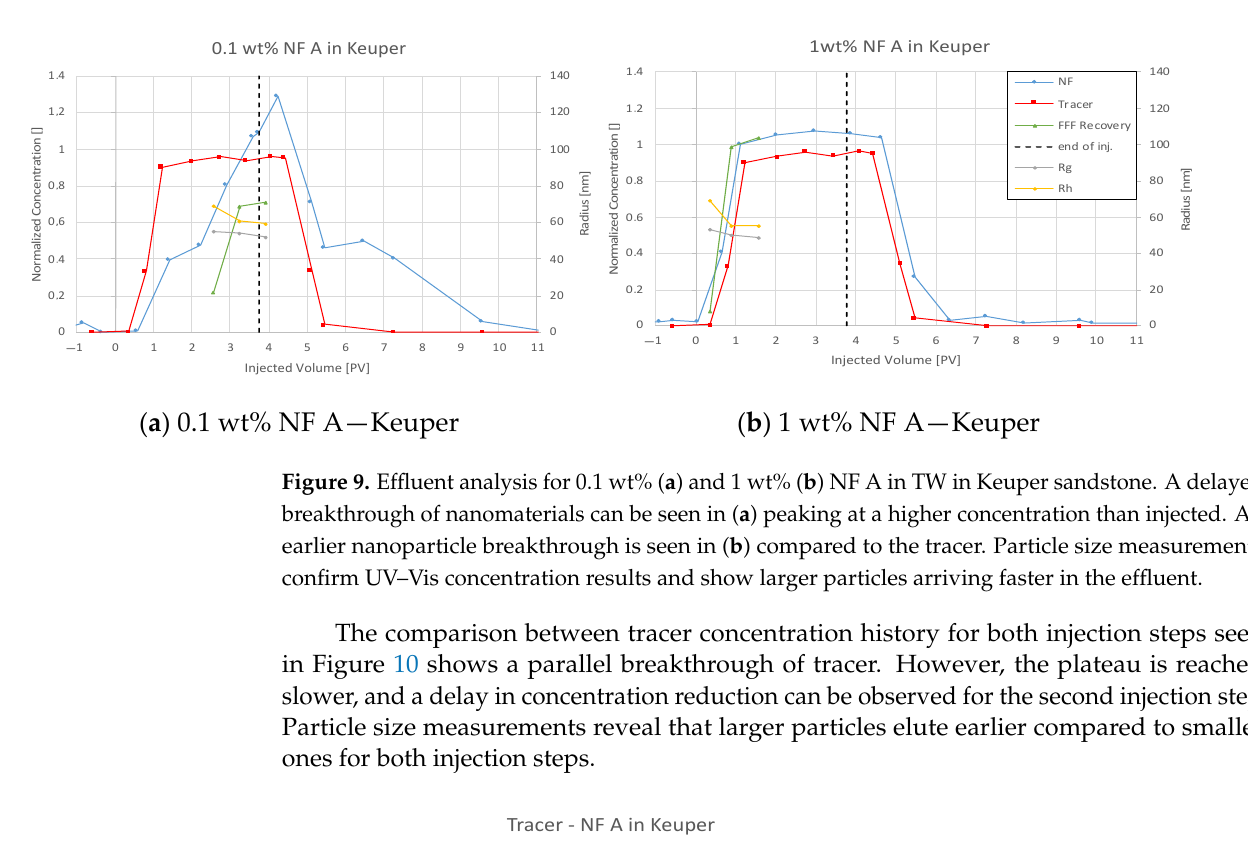
Figure 10. Tracer concentration history for Nanofluid A in Keuper in two injection steps. An identical tracer breakthrough can be observed at 0.9 PV (50%), whereas the plateau is reached slower. A delayed decrease in concentration for the second injection step can be observed.